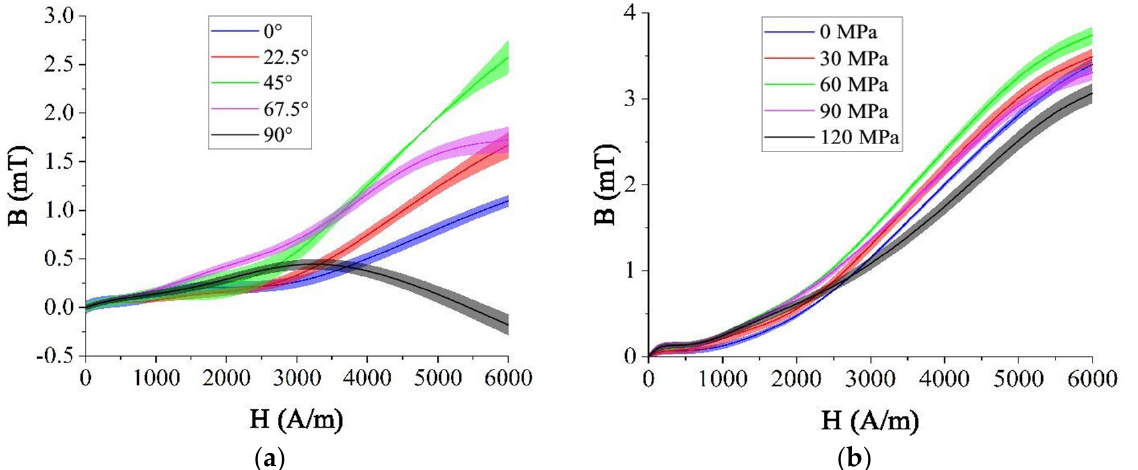
Figure 15. Error bars of magnetization measurements for specimens ( a ) at different angles, ( b ) at